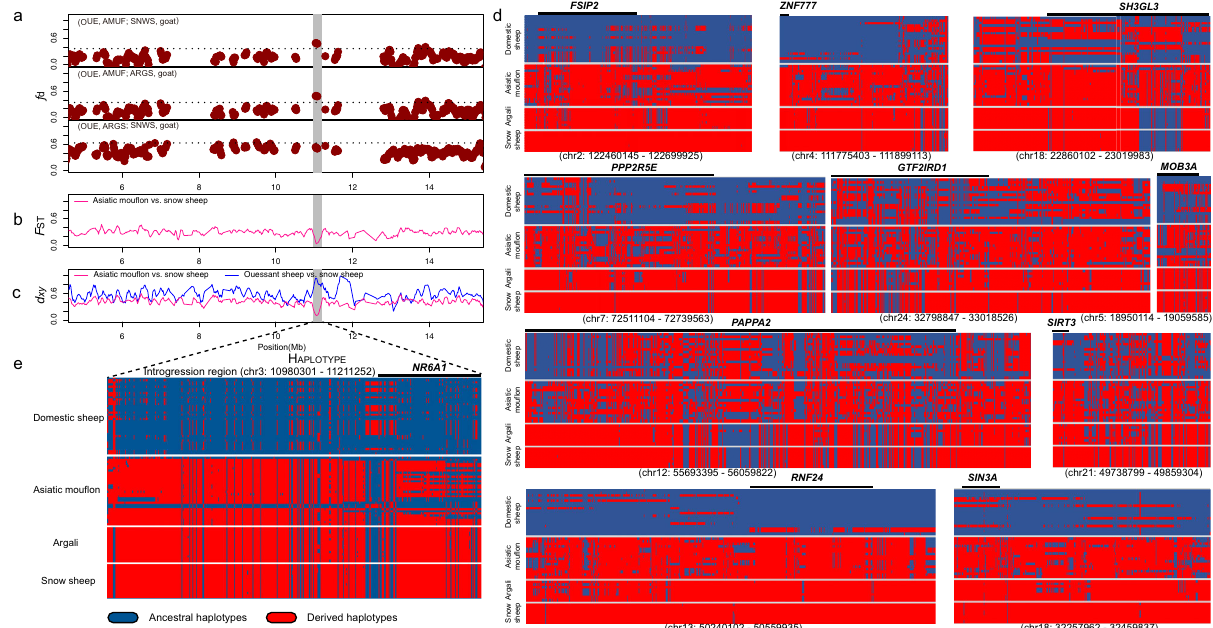
Fig. 6 Local inference of genomic region at genes introgressed from snow sheep (SNWS) into Asiatic mou fl on (AMUF). a f -statistics ( f d ) based on (OUE, AMUF; SNWS, goat) comparison with (OUE, AMUF; ARGS, goat) and (OUE, ARGS; SNWS, goat) calculated for 100-kb windows with 20-kp steps across the genome for Asiatic mou fl on. Each dot represented a 100-kb window, and the dashed line indicated the signi fi cance threshold ( P < 0.05). b Population differentiation ( F ST ) around the introgressive genomic region between recipient (Asiatic mou fl on) and donor (snow sheep). c Mean pairwise sequence divergence ( d xy ) of the introgression region between snow sheep and either Asiatic mou fl on or Ouessant (OUE) domestic sheep population. d , e Haplotype patterns among all the domestic sheep, Asiatic mou fl on, argali, and snow sheep for the 11 genomic regions. Genes within the introgressed segments were marked above